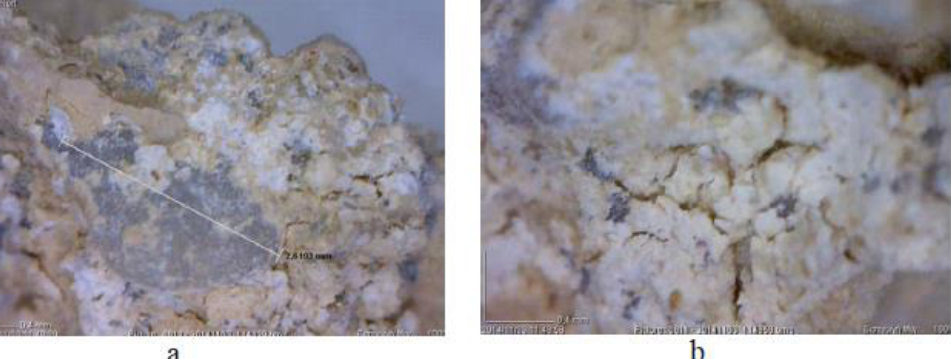
Figure 12. ( a ) Microphotographs of the mortar sample show the presence of pozzolan tracers and gray grains of aggregates, the length of which reached 2.61 mm, ( b ) a thin off-white layer corresponding to the carbonate matrix. (Reprinted with permission from Ref. [24]. Copyright: 2017 Ftikou, E.; Theodorakeas, P. ; Cheilakou, Ε . ; Koui, Μ .).